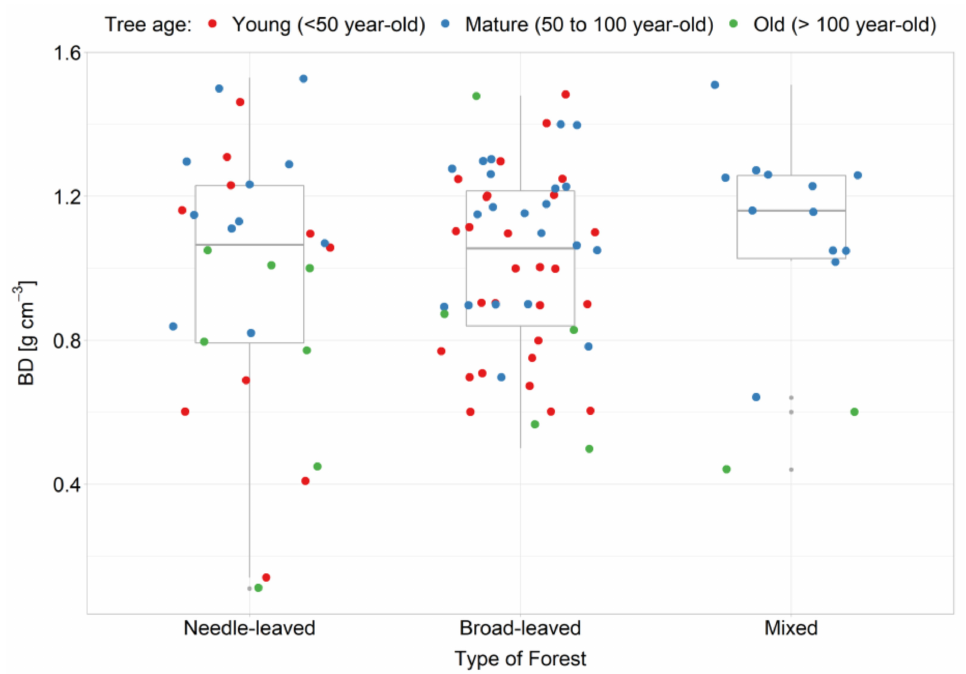
Figure 3. Descriptive statistics of the top mineral soil bulk density in relation to the tree age and forest type for dataset B. Scattered points represent the individual values classified by the different forest stages. Values correspond to the 0–30 cm soil depth. Grey points indicate the outliers. Table 4. Summary of reported values on topsoil bulk density and hydraulic conductivity for the different forest types, data are subdivided based on the information on tree age: young (Y) less than 50 years, mature (M) 50 to 100 years, and old (O) more than 100